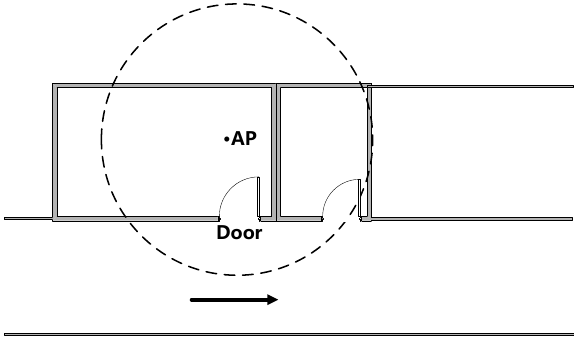
Figure 4. Door with an AP inside.